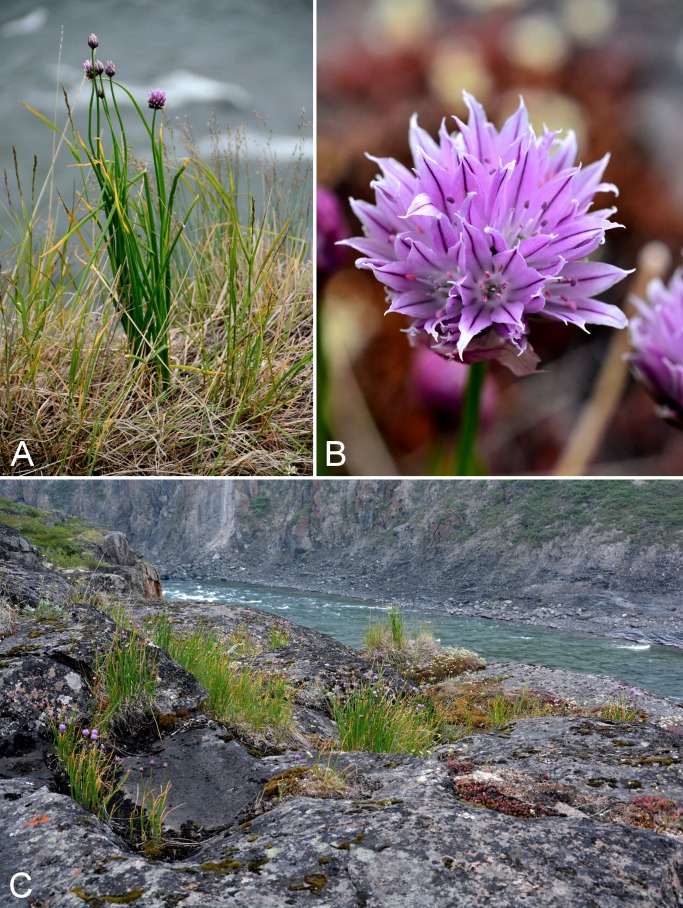
Allium schoenoprasum.(A) Habit, Saarela et al. 3935. (B) Inflorescence, Saarela et al. 3935. (C) Habitat, Saarela et al. 3935. Photographs by R. D. Bull (A) and P. C. Sokoloff (B, C).